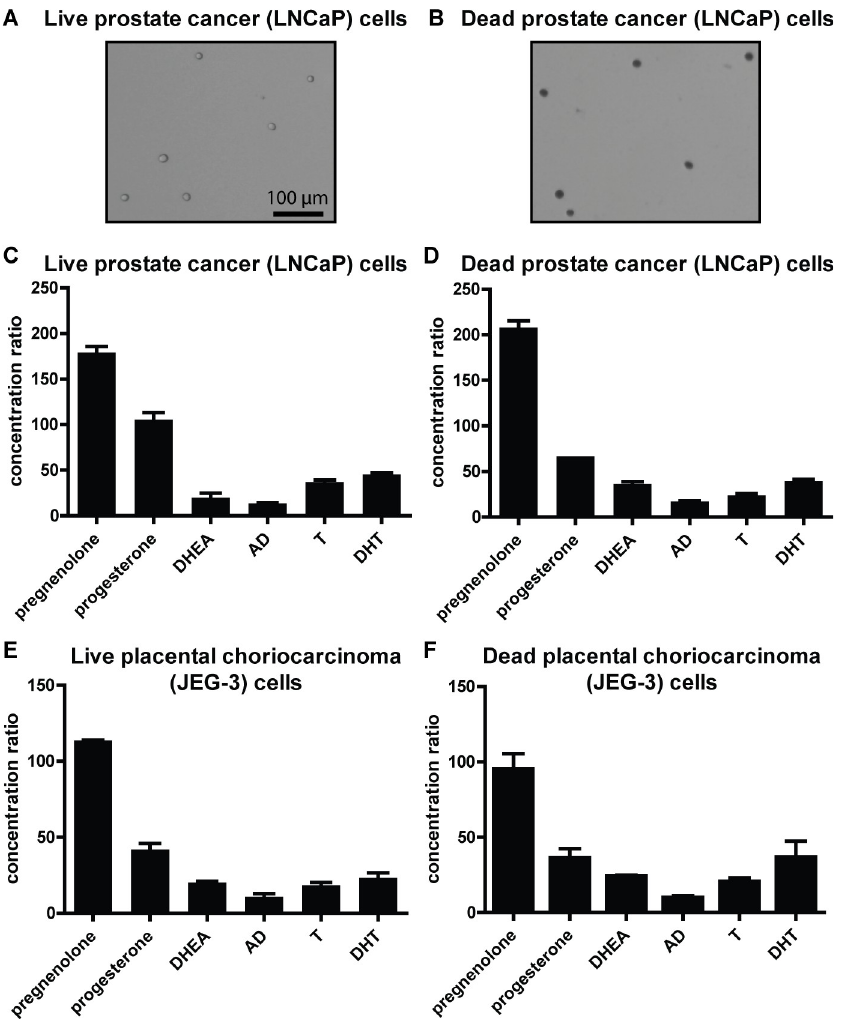
Fig 2. Cellular preferences for progestogens and 3 β -OH, Δ 5 -steroids are independent of cell viability. (A-B) Live (A) and heat-killed (B) LNCaP cells exposed to trypan blue stain. Note the staining of the heat-killed cells, and note also that the live and dead cells are similar from a gross morphological standpoint. (C-D) Ratios of cellular concentrations to original treatment concentrations in culture media for six different steroids in live (C) and dead (D) LNCaP cells incubated in tubes. (E-F) Ratios of cellular concentrations to original treatment concentrations in culture media for six different steroids in live (E) and dead (F) JEG-3 cells incubated in tubes. All graphs show mean ± SD from one representative experiment with biological duplicates and all experiments were performed at least